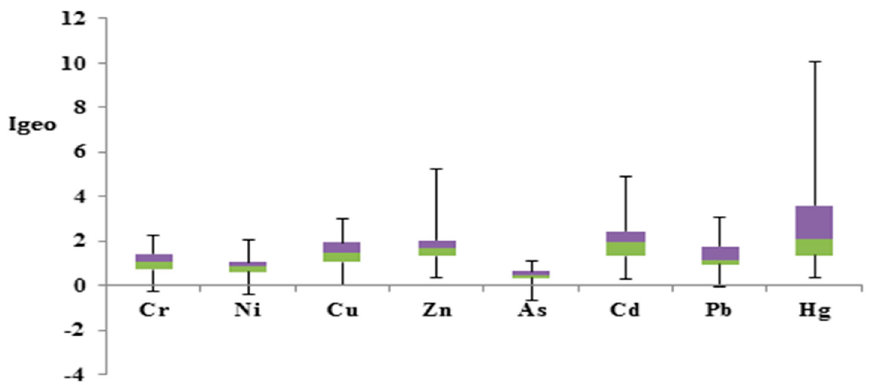
Figure 4. Boxplot of I geo (Green color= Quartile group 2, 25%), (Purple color= Quartile group 3, 25%).